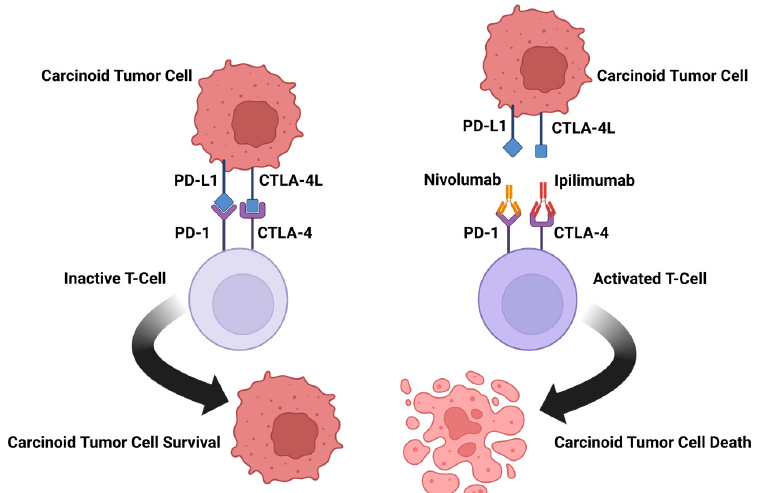
Figure 1. Mechanism of action for the combination of ipilimumab and nivolumab. Carcinoid tumor cells can express PD-L1 and CTLA-4L. These ligands can bind PD-1 and CTLA-4 to inactivate T cells. By blocking the PD-1 and CTLA-4 receptors on T cells, the T cells remain active and capable of mounting an immune response against carcinoid tumor cells. In this way, the combination of ipilimumab and nivolumab suppress this type of cancer immune escape.